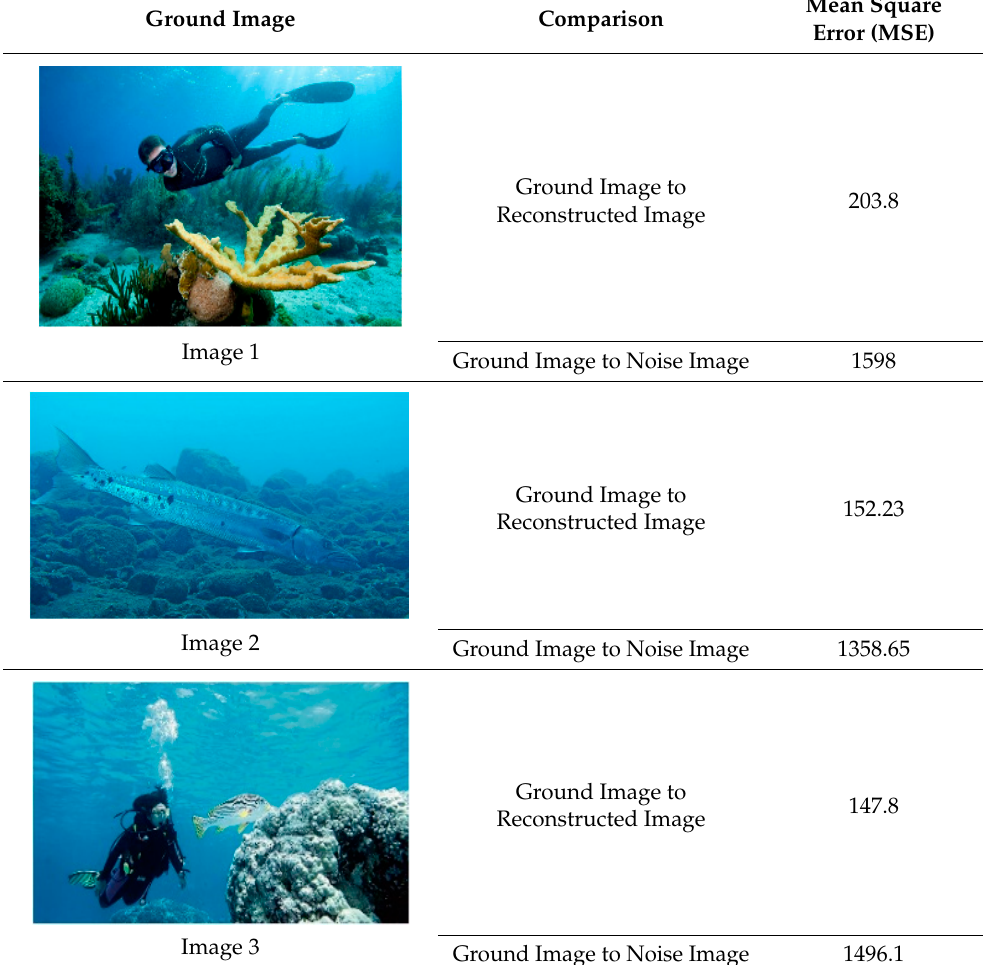
Table 2. Mean Squared Error (MSE) of Images. Ground Image Comparison